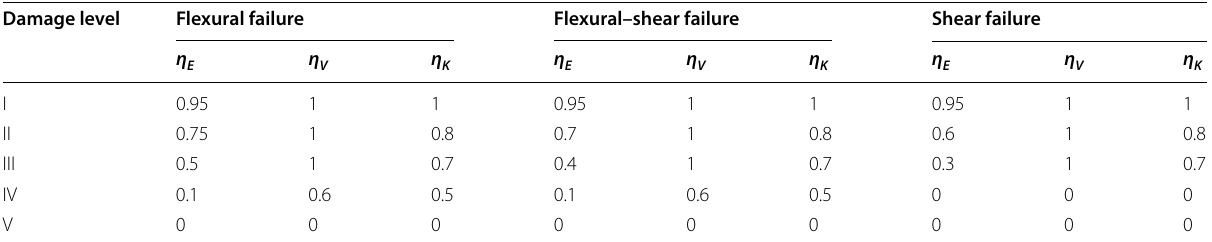
Table 13 Suggested reduction factors of energy dissipation capacity strength and stiffness for RC column members. Damage